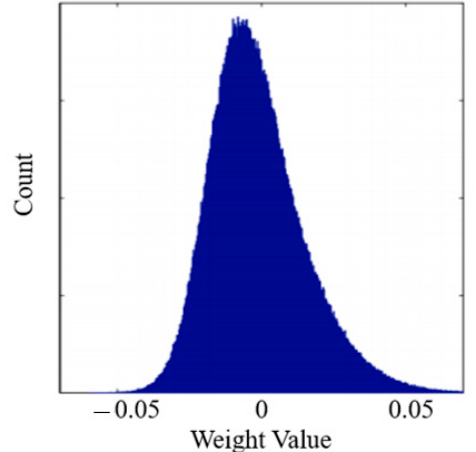
Figure 3. Model weight distribution before ReLU.